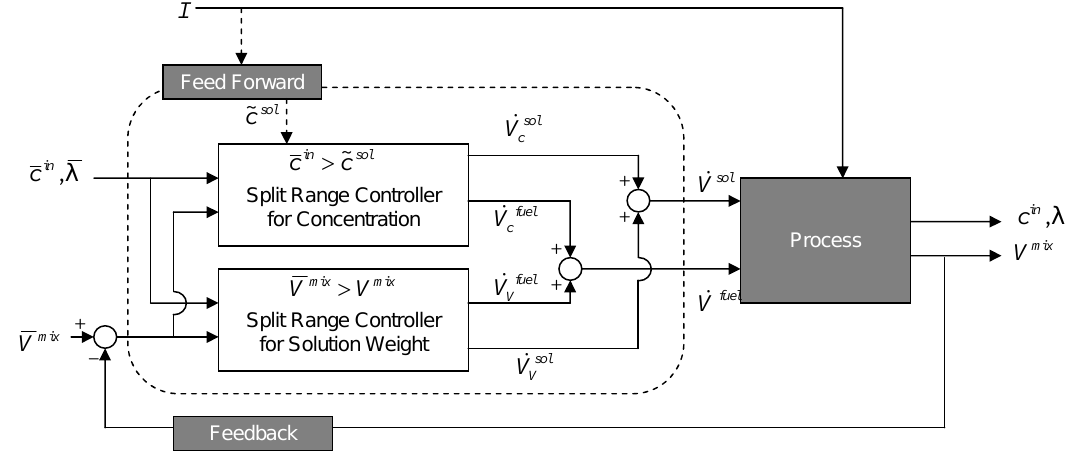
Figure 5. The block diagram of the concentration controller in the separate tank